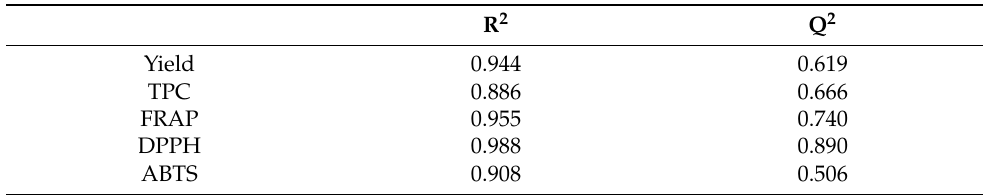
Table 2. Goodness-of-fit coefficients of statistical